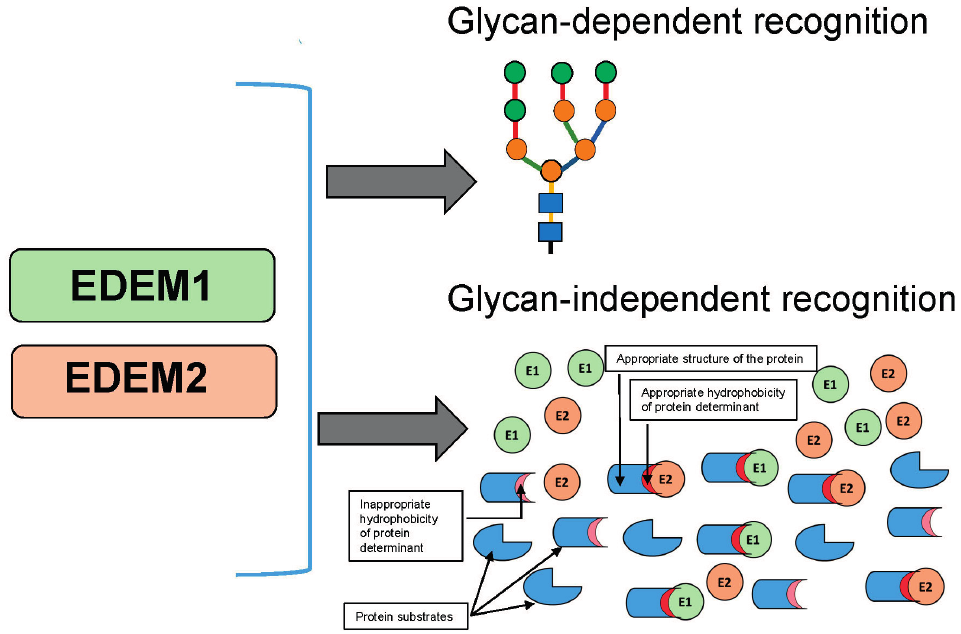
Figure 3. Glycan-dependent and glycan-independent interactions of EDEM1 and EDEM2 with protein substrates. For glycan-independent interactions with EDEM family chaperones both appropriate conformation and hydrophobicity of proteins seem to be important (see text). E1 is for EDEM1, E2 is for